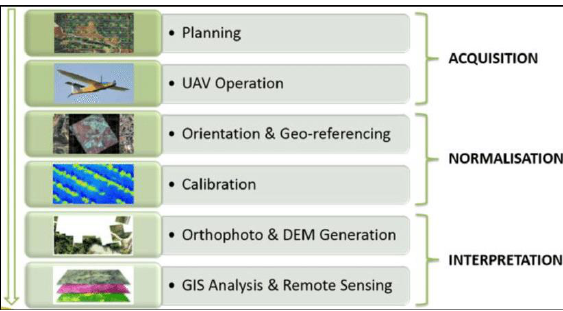
Figure.2. General flow chart for 3D mapping using UAV (Khaula and Abdelgadir,